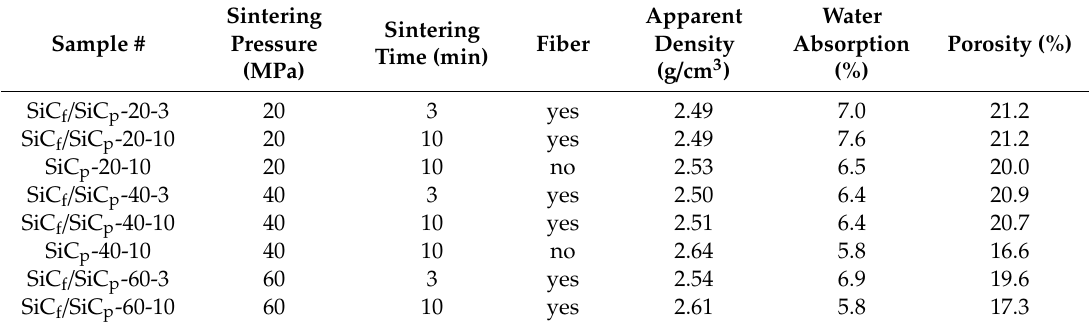
Table 1. Properties of the silicon carbide fiber / paper-derived silicon carbide (SiC f / SiC p ) composite materials sintered at 2100 °C.